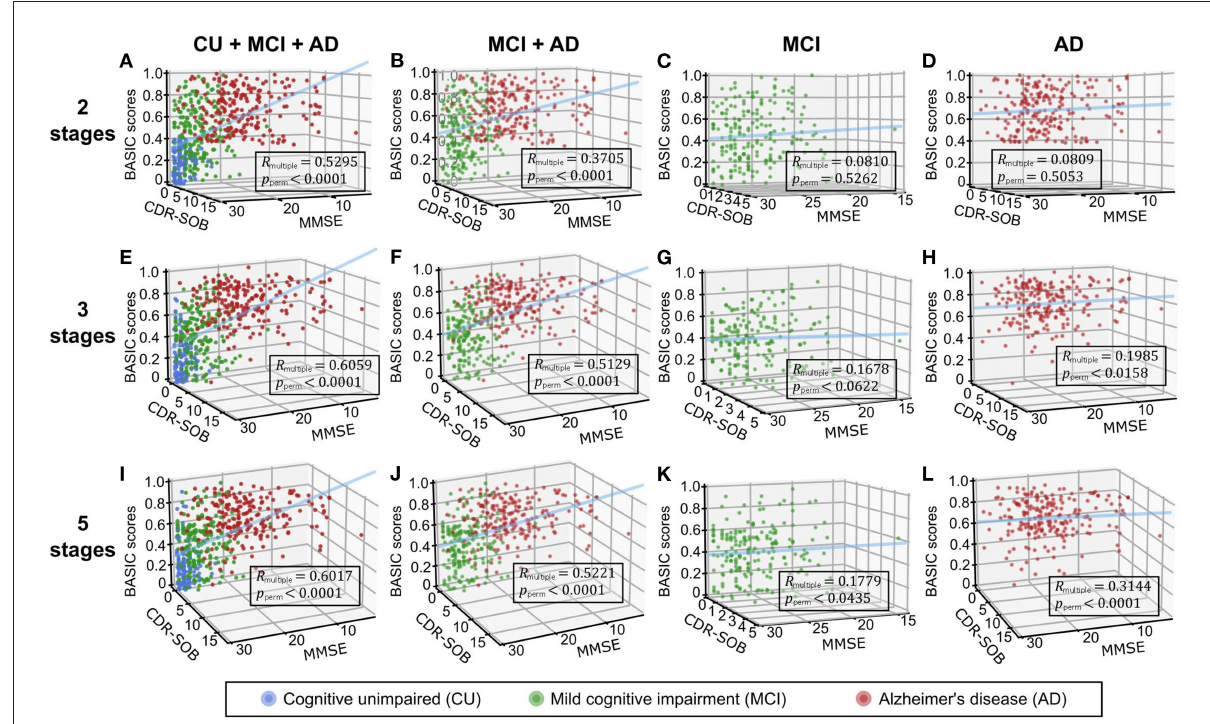
FIGURE4 Three-dimensional regression plots with cognitive functioning scores, including the mini-mental state examination (MMSE) and clinical dementia rating scale-sum of boxes (CDR-SOB) as independent variables and BASIC scores as dependent variables. Participants in two (A-D) , three (E-H) , and five (I-L) stages of Alzheimer’s disease (AD) were used to determine the BASIC scores. The coefficients of multiple correlations ( R multiple ) between BASIC scores and cognitive functioning scores were represented as p -values ( p perm ) using 10,000 permutations for each plot. CU, cognitively unimpaired; MCI, mild cognitive